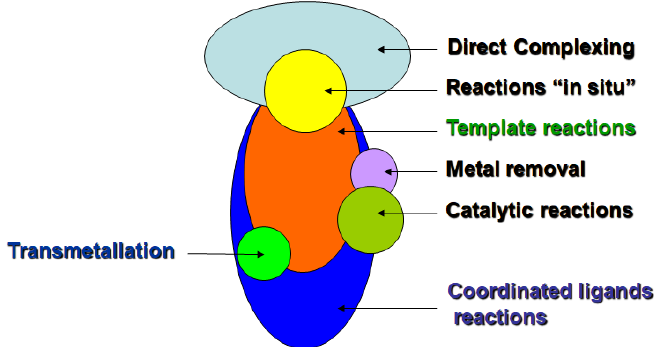
Figure 2. The place of template processes in modern coordination chemistry.